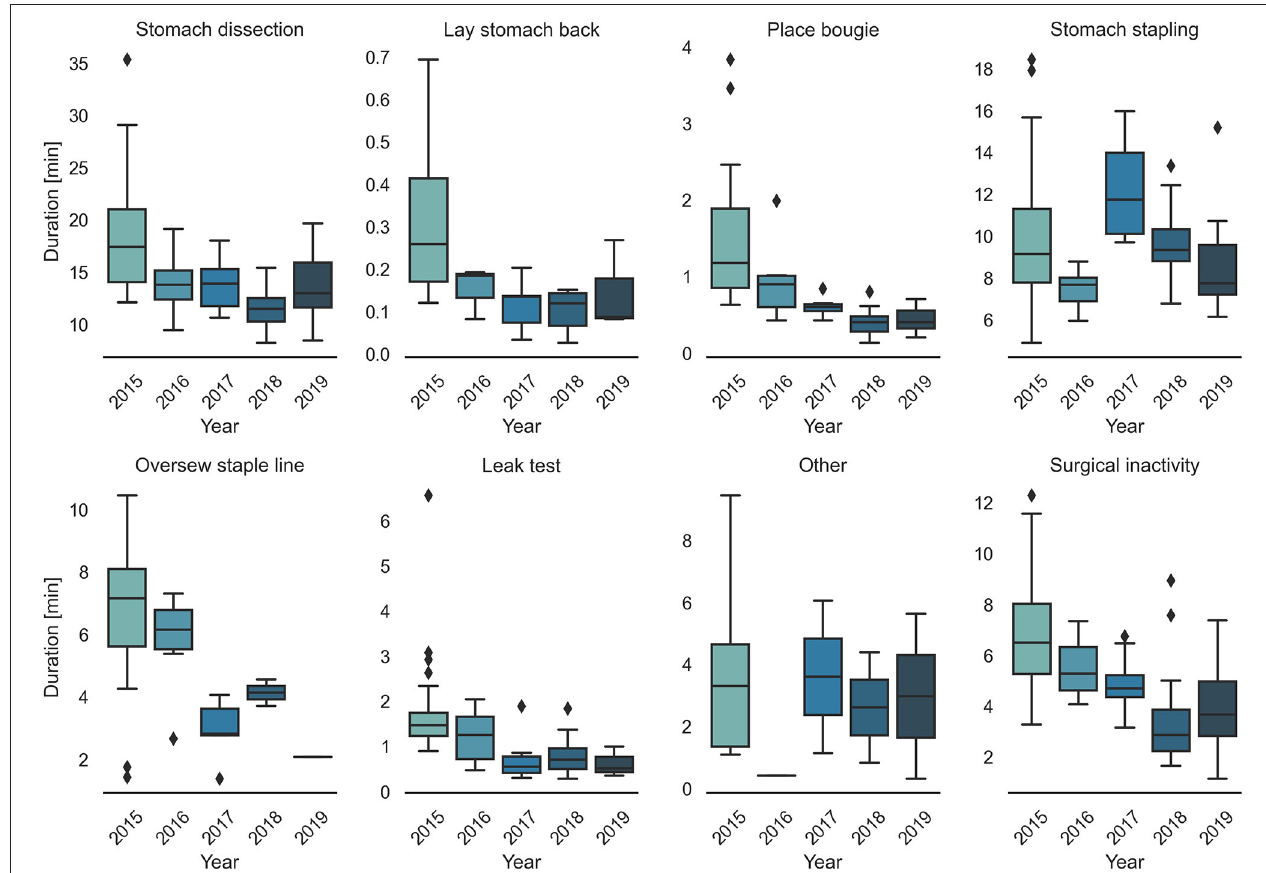
FIGURE 2 | Trend in task duration change of all 77 cases over five